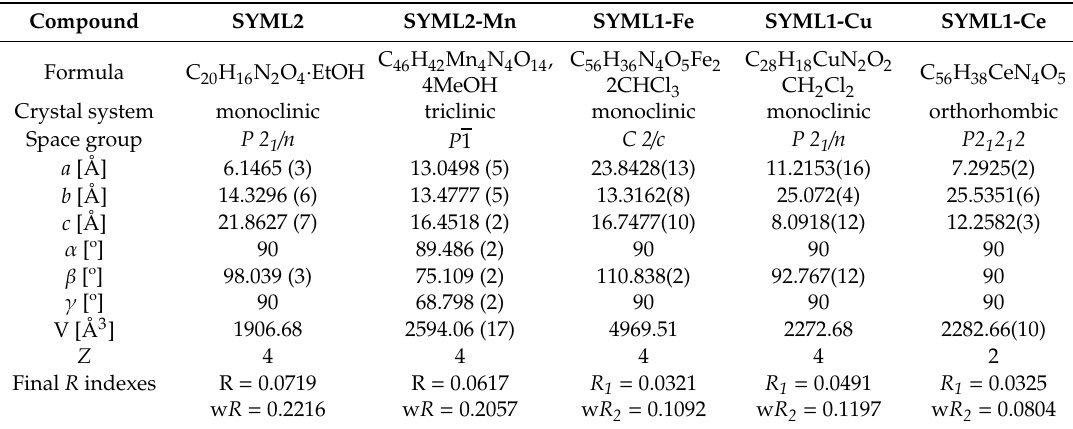
Table 1. Crystallographic and data collection parameters for SYML2, SYML1-Ce, SYML1-Fe, SYML1-Cu, and SYML2-Mn, all collected at 100